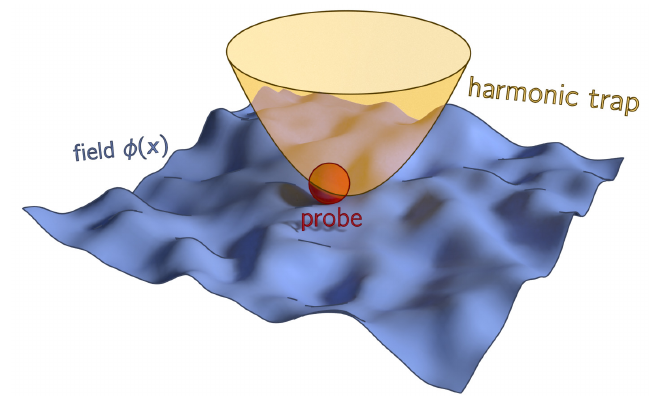
Figure 1: Schematic representation of the model: The colloidal probe particle (dark red sphere) is in contact with a fluctuating scalar field φ ( x ) and is subject to the force exerted by a harmonic